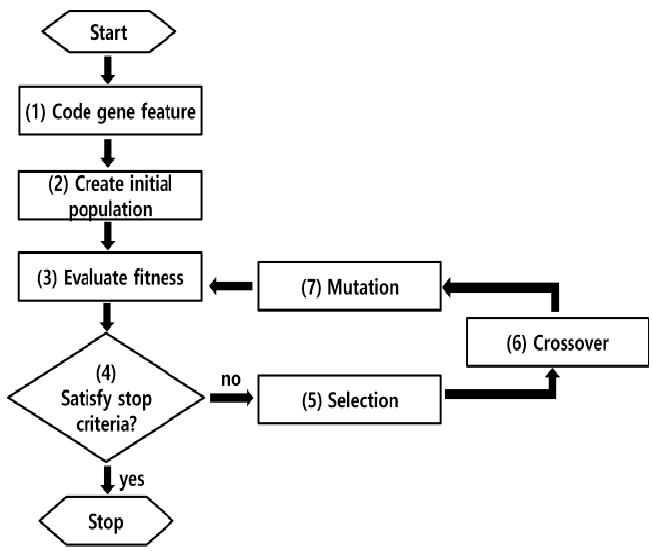
Figure 2. Process for deducing optimal solution using Genetic Algorithm (GA).